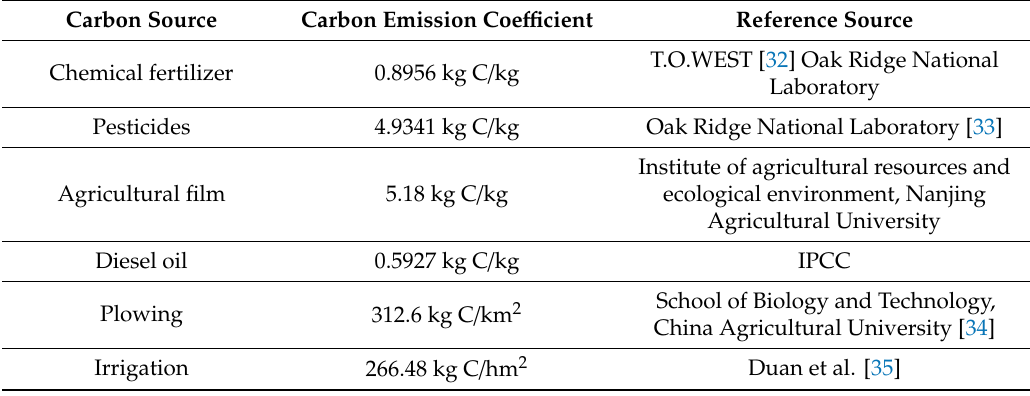
Table 1. Emission coe ffi cients of main carbon sources.